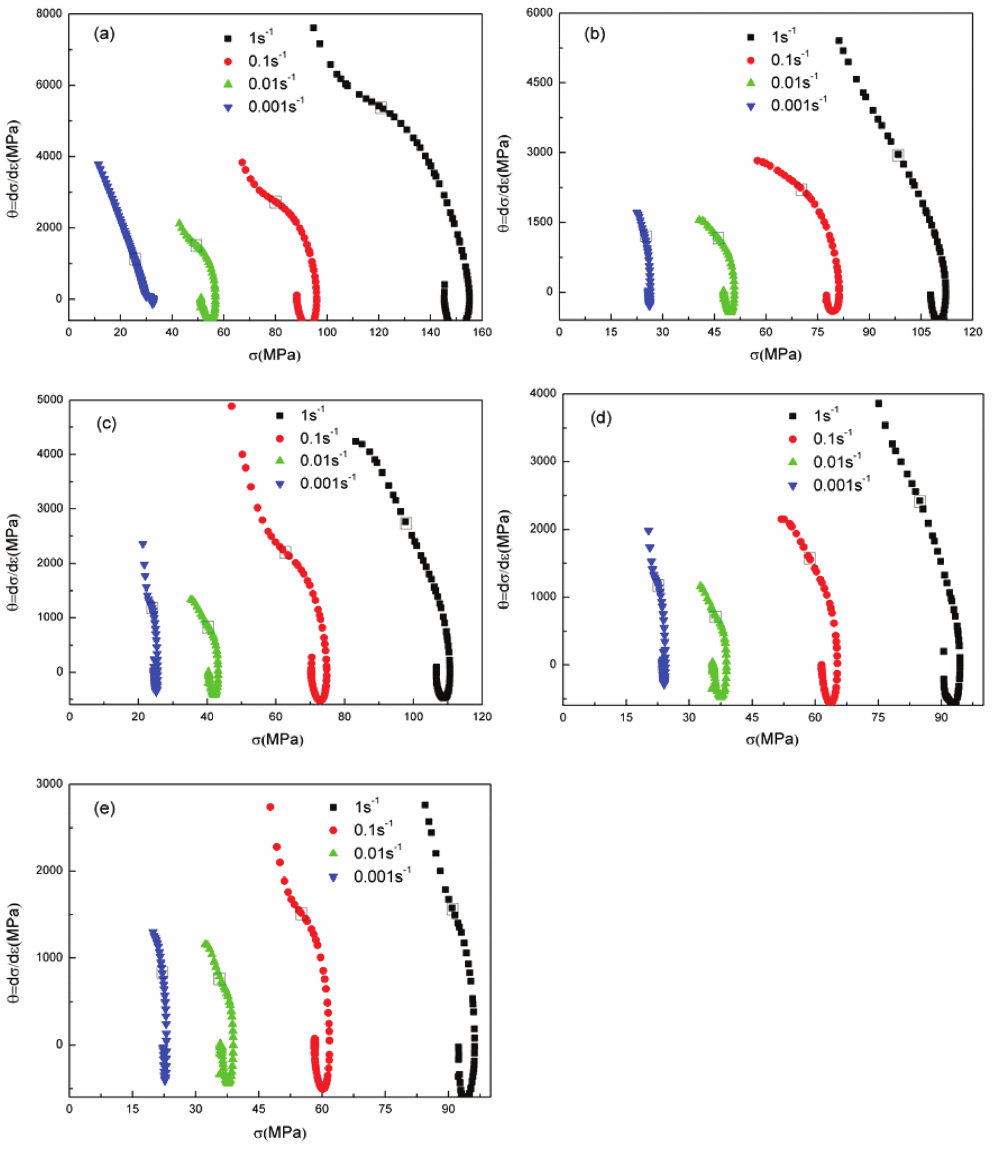
Figure 8: θ – σ curves of BT25y alloy under different deformation conditions: (a) 1,213 K; (b) 1,233 K; (c) 1,253 K; (d) 1,273 K; (e) 1,293